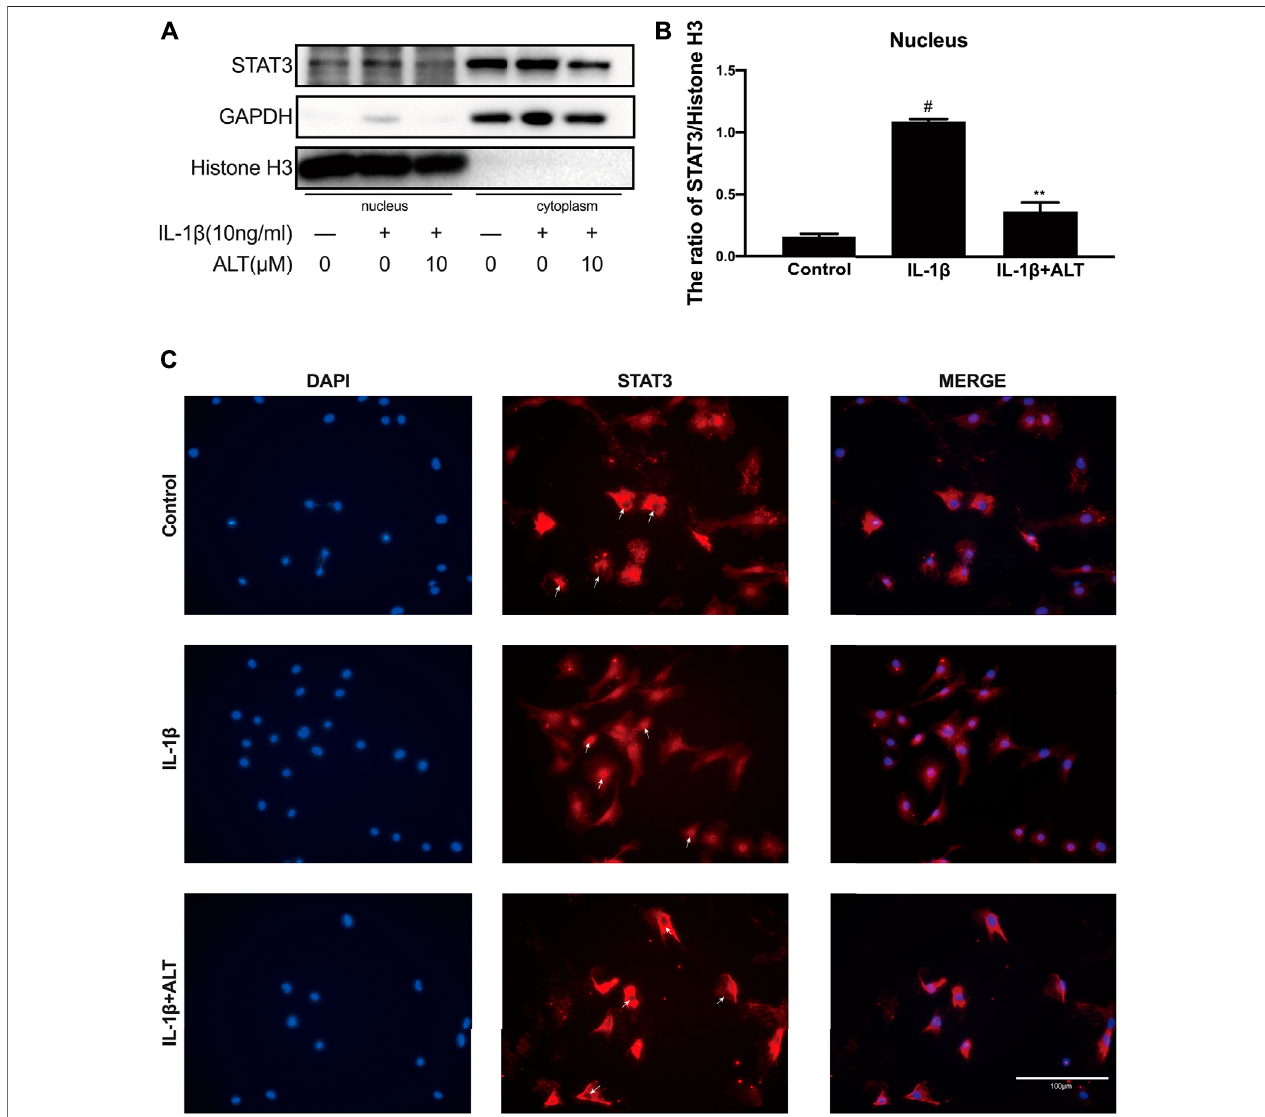
FIGURE 7 | ALT suppressed IL-1 β -induced STAT3 translocation in mouse chondrocytes. Mouse chondrocytes were treated with or without ALT (10 μ M) and stimulated with IL-1 β (10 ng/ml) for 2 h. (A) Protein level of STAT3 in nucleus was detected by Western blot. (B) Relative protein expression was quali fi ed by ImageJ software, Histone H3 was used as the loading control ( n (cid:2) 3). (C) STAT3 translocation was observed by Immuno fl uorescence (scale bar 100 μ m). # p < 0.05 vs. control group; * p < 0.05 vs. IL-1 β group; ** p < 0.01 vs. IL-1 β group.